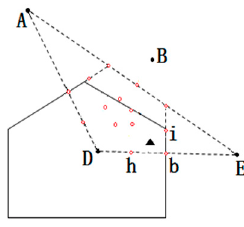
Figure 10. Closest virtual reference nodes.